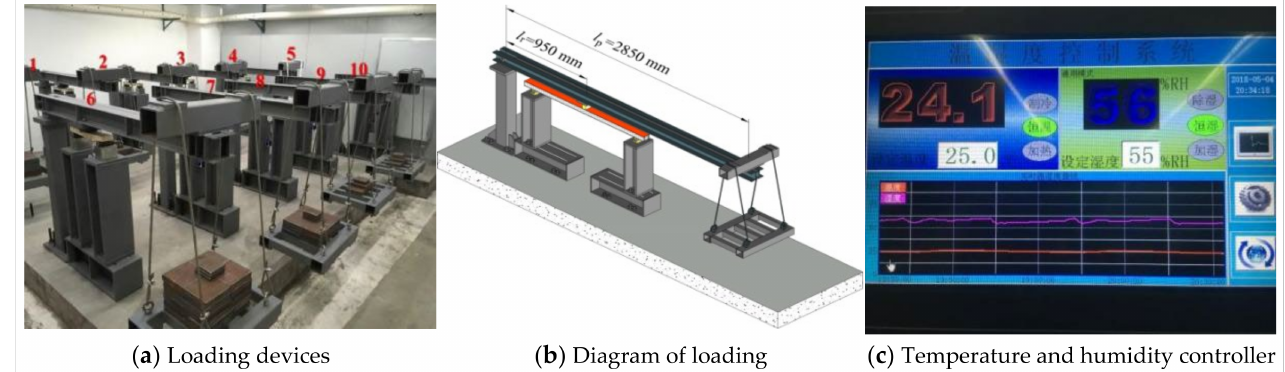
Figure 3. Three-point bending creep test loading